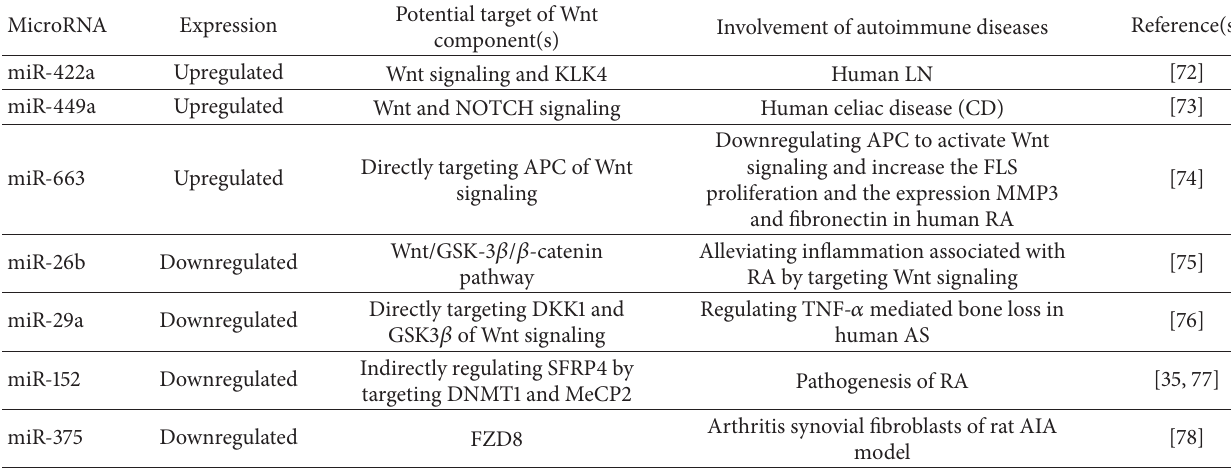
Table 2: MicroRNAs target Wnt signaling in autoimmune